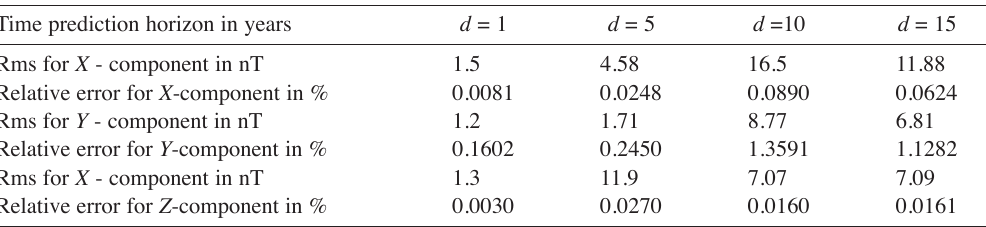
Table II. Rms and relative errors of prediction (second way of data input).